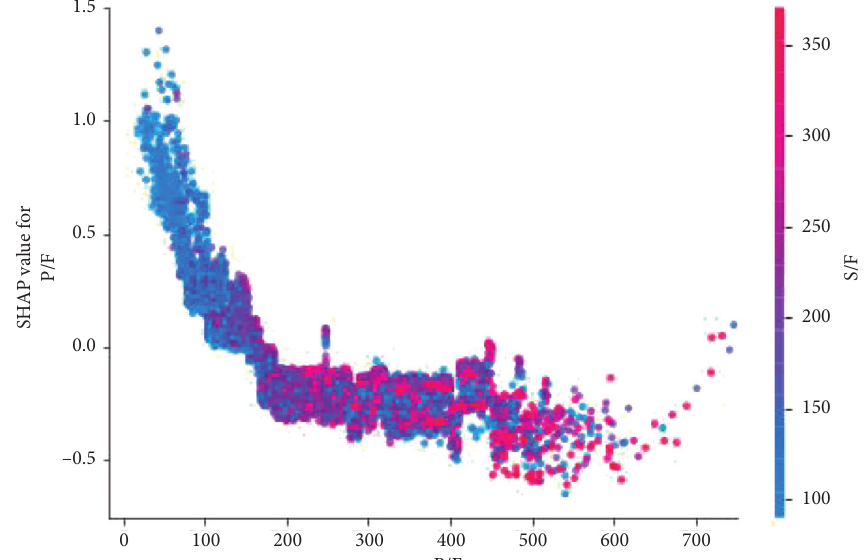
Figure 7: P/F partial dependence plot. The y -axis on the left reflects the probability of death as a positive value denotes a higher probability. The y -axis on the right shows the color scale of the value of S/F, which is superimposed upon the P/F plot. The x -axis demonstrates the S/F value. As P/F decreases, the probability of death increases. Probability of death appears to rise significantly below a P/F value of 200. S/F and P/F demonstrate a strong correlation, with both the quantitative value and changes in the probability of death. P/F: PaO 2 and FiO 2 ratio; S/F: SaO 2 and FiO 2 plotted by mortality. As expected, this violin plot shows that the patients who survived had higher oxygen saturations, with a greater number of patients with saturations closer to their median as compared to the EXPIRED group. SaO : 2 oxygen saturation. Supplemental Figure 3: violin plot dis- tribution of S/F ratio plotted by mortality. The interquartile range extends over a wider range of S/F ratios in the patients who survived. The difference in the FiO ratios between the 2 two groups in Figure 1 alone does not account for the median that is nearly double in the ALIVE versus the EXPIRED group. To further support this point, the number of patients with S/F ratios close to the median is greater than that in the FiO violin plot. S/F: ratio of oxygen saturation 2 and fraction of oxygen in inspired air. Supplemental Fig- ure 4: violin plot distribution of age plotted by mortality. Age was not a particularly important feature in predicting risk for ICU mortality in the patients included. Though the medians are different, there is a similar density of patients of the same age range in both groups. Supplemental Figure 5: violin plot distribution of P/F ratio plotted by mortality. Although P/F ratios span over a wider range of values than S/F ratios do based on the S/F’s ratio’s numerator being a percentage, P/F was less predictive of ICU mortality in a narrow range of values. P/F: ratio of partial pressure of oxygen and fraction of Supplemental Figure 1: violin plot distribution of FiO 2 oxygen in inspired air. Supplemental Figure 6: distribution plotted by mortality. The median FiO of survivors was 2 of admission diagnoses. Our inclusion criteria allowed for a approximately 50%, whereas expired patients had a median FiO of 80%. The thick gray bar in the middle of each plot 2 represents the interquartile ranges above and below the median. Here we see that the 75% quartile of patient in the ALIVE group still had a lower FiO than the median in the 2 expired group. FiO : fraction of oxygen in inspired air. 2 Supplemental Figure 2: violin plot distribution of SaO 2